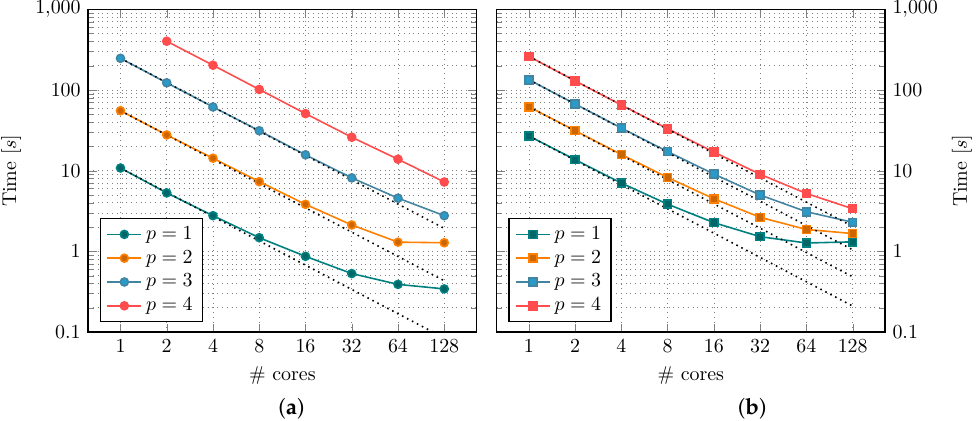
Figure 12. Parallel scalability of ( a ) AMG and ( b ) GMG for varying p . Average time spent for the solution of a linear system is